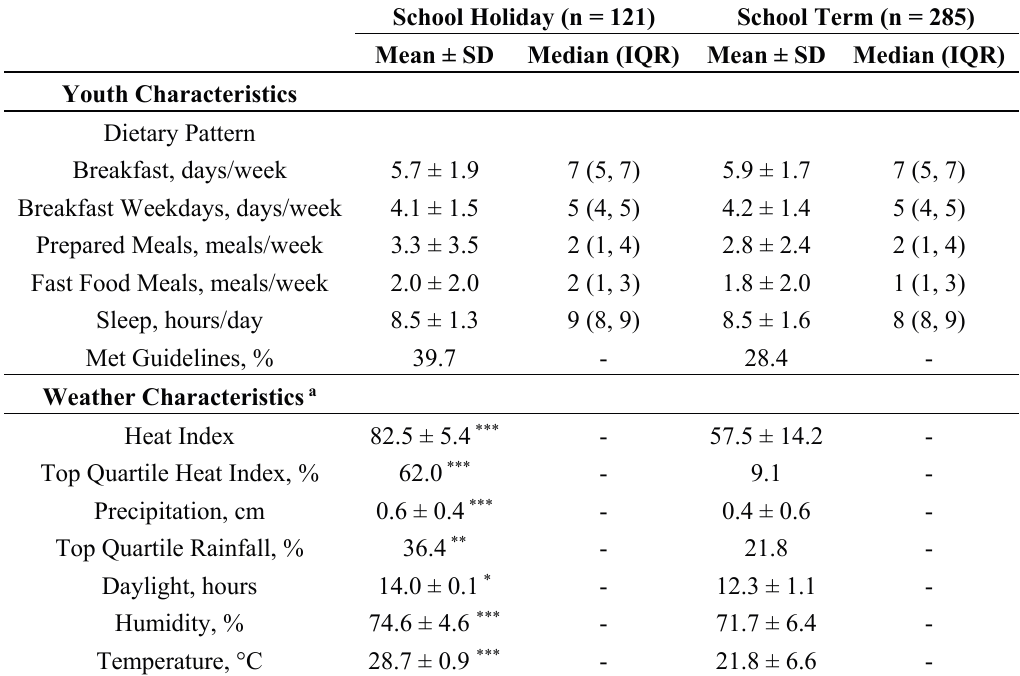
Table 1. Cont. School Holiday (n =